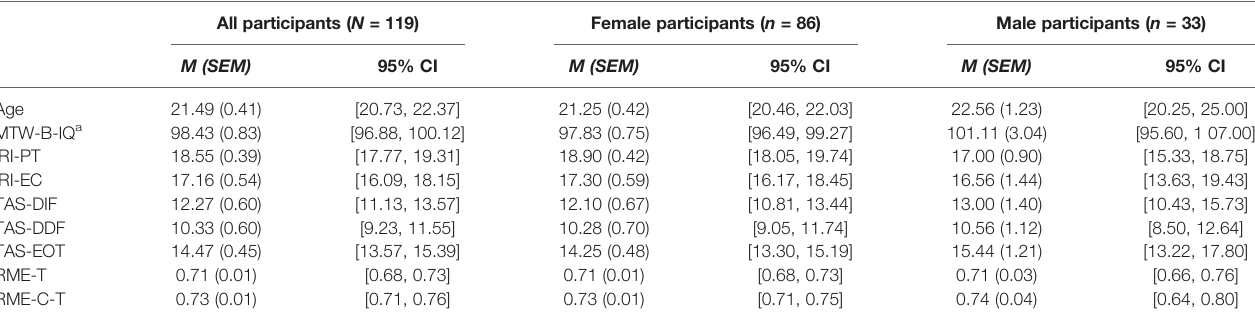
TABLE 1 | Participant